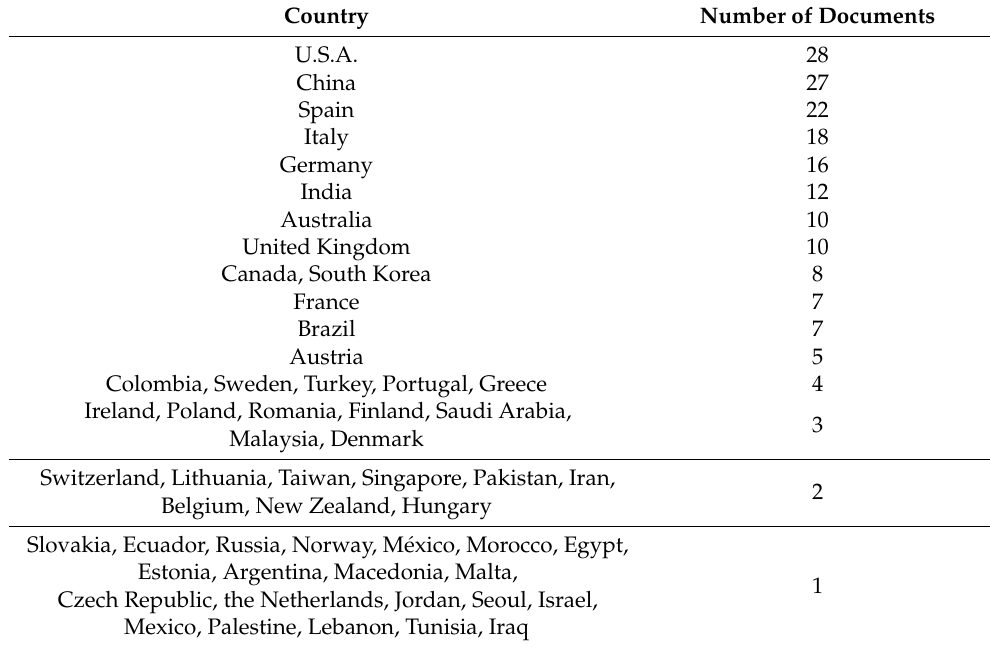
Table 3. Scientific contribution by country.